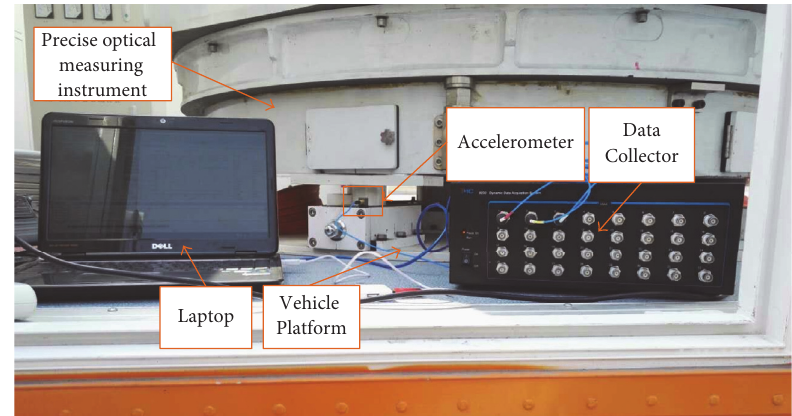
Figure 13: The apparatus of vehicle platform vibration test.